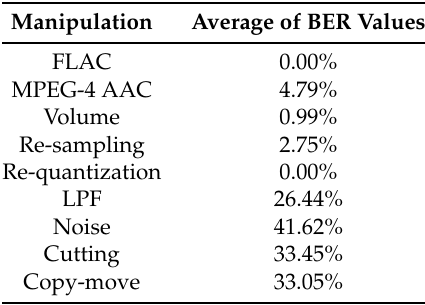
Table 7. Results of perceptual and non-perceptual tests for 500 signals.